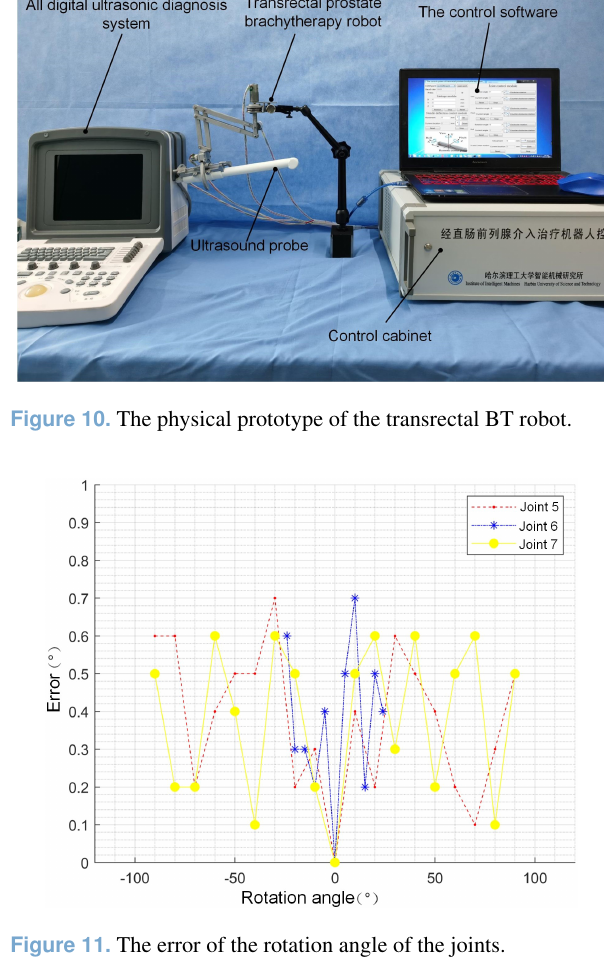
angle range and realize continuous rotation, while also meet- ing the actual clinical needs.